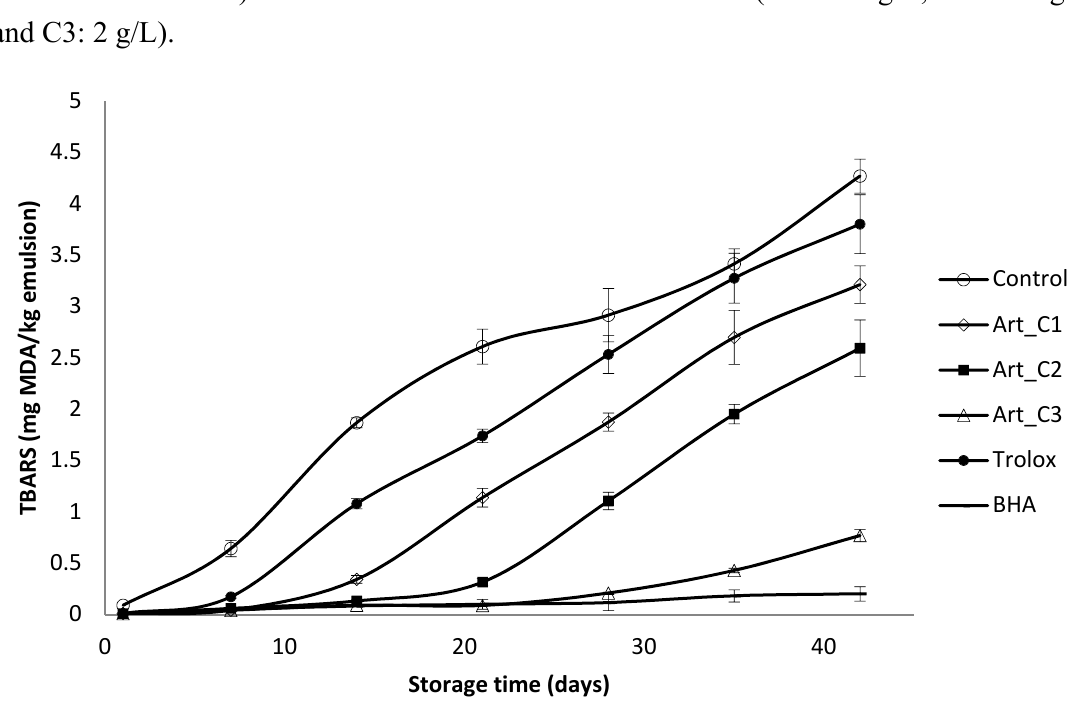
Figure 3. Evaluation of secondary oxidation (TBARs) in a model food system (O/W emulsion 10% of oil) with different concentration of A. annua (C1: 0.20 g/L; C2: 0.65 g/L and C3: 2